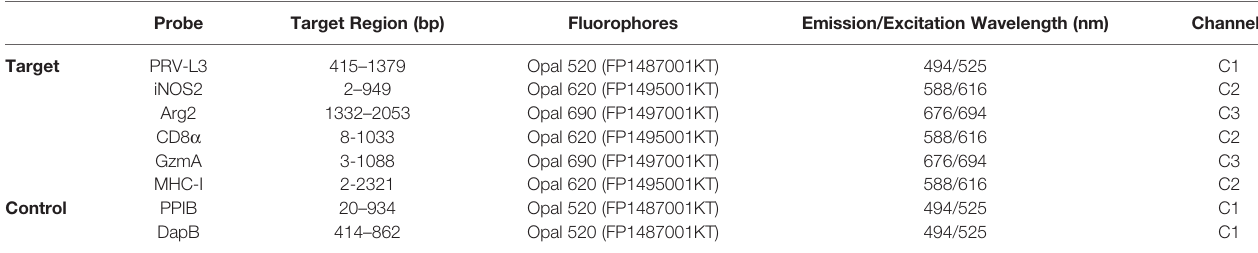
TABLE 3 | List of probes and corresponding fl uorophores used in FISH.